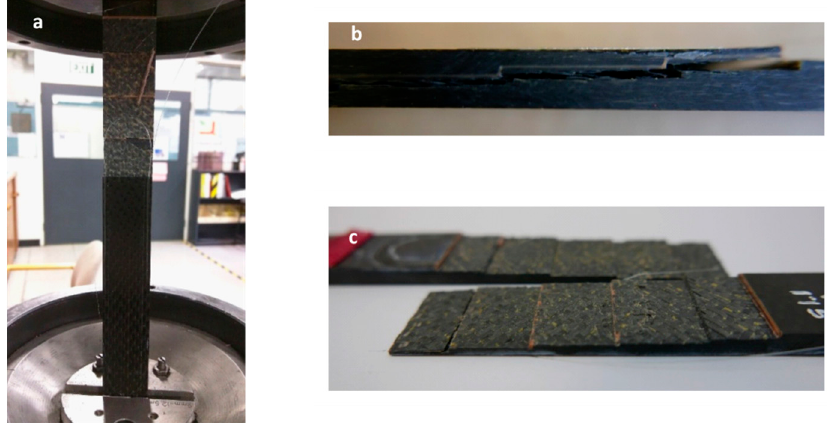
Figure 11. ( a ) Failed specimen; ( b ) side view of the failed specimen; and ( c ) the features of failed specimen along the bondline.